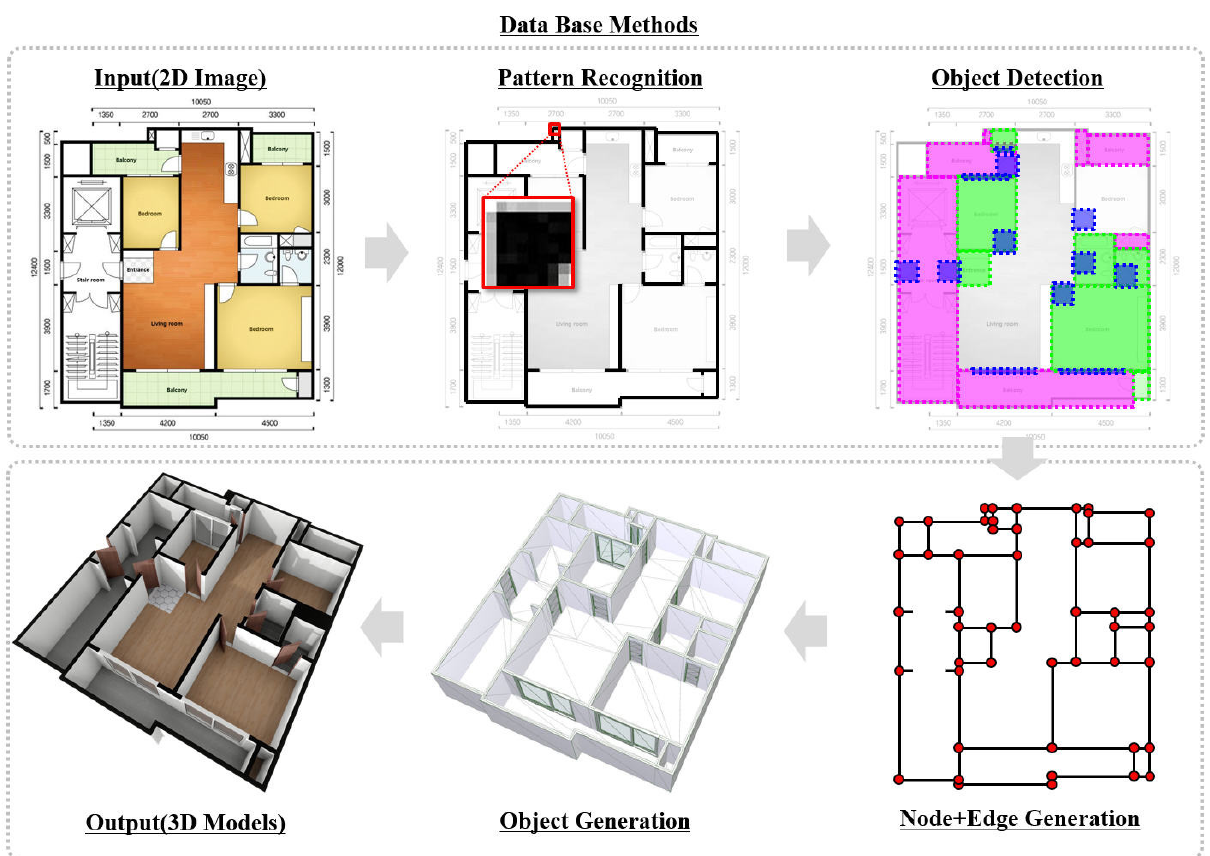
Figure 1. To convert a 2D raster floorplan (input) into 3D vector models (output), we propose 3DPlanNet Ensemble methods that combine data (learning) based methods and rule (heuristic) based